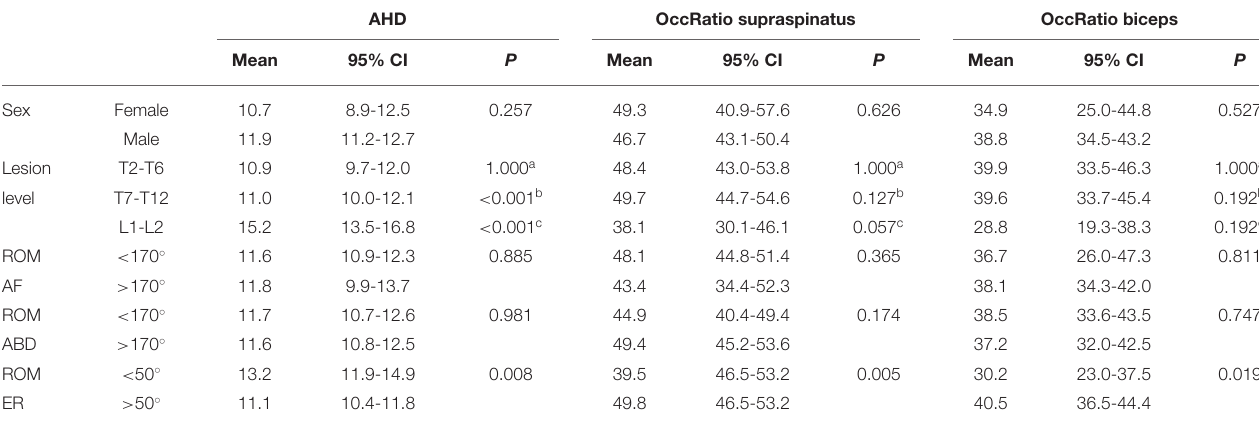
TABLE 3 | Predictive margins with 95% confidence interval (95% CI) of acromiohumeral distance (AHD) and occupation ratio (OccRatio) of supraspinatus and biceps for categorical covariables sex, lesion level, shoulder range of motion in anteroflexion (AF), external rotation (ER) and abduction (ABD): predictive margins with 95% confidence